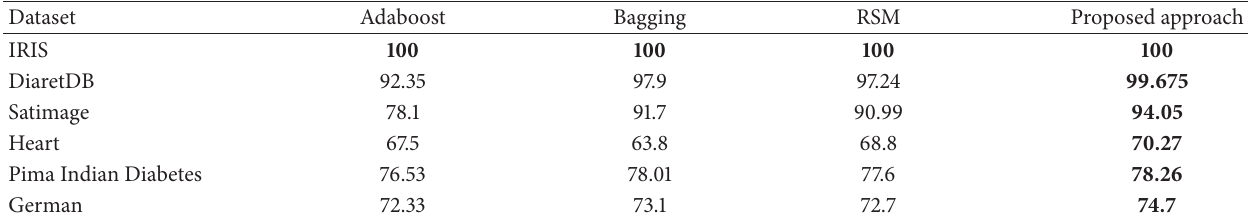
Table 5: Classification accuracies of competitors using different number of training iterations. Dataset